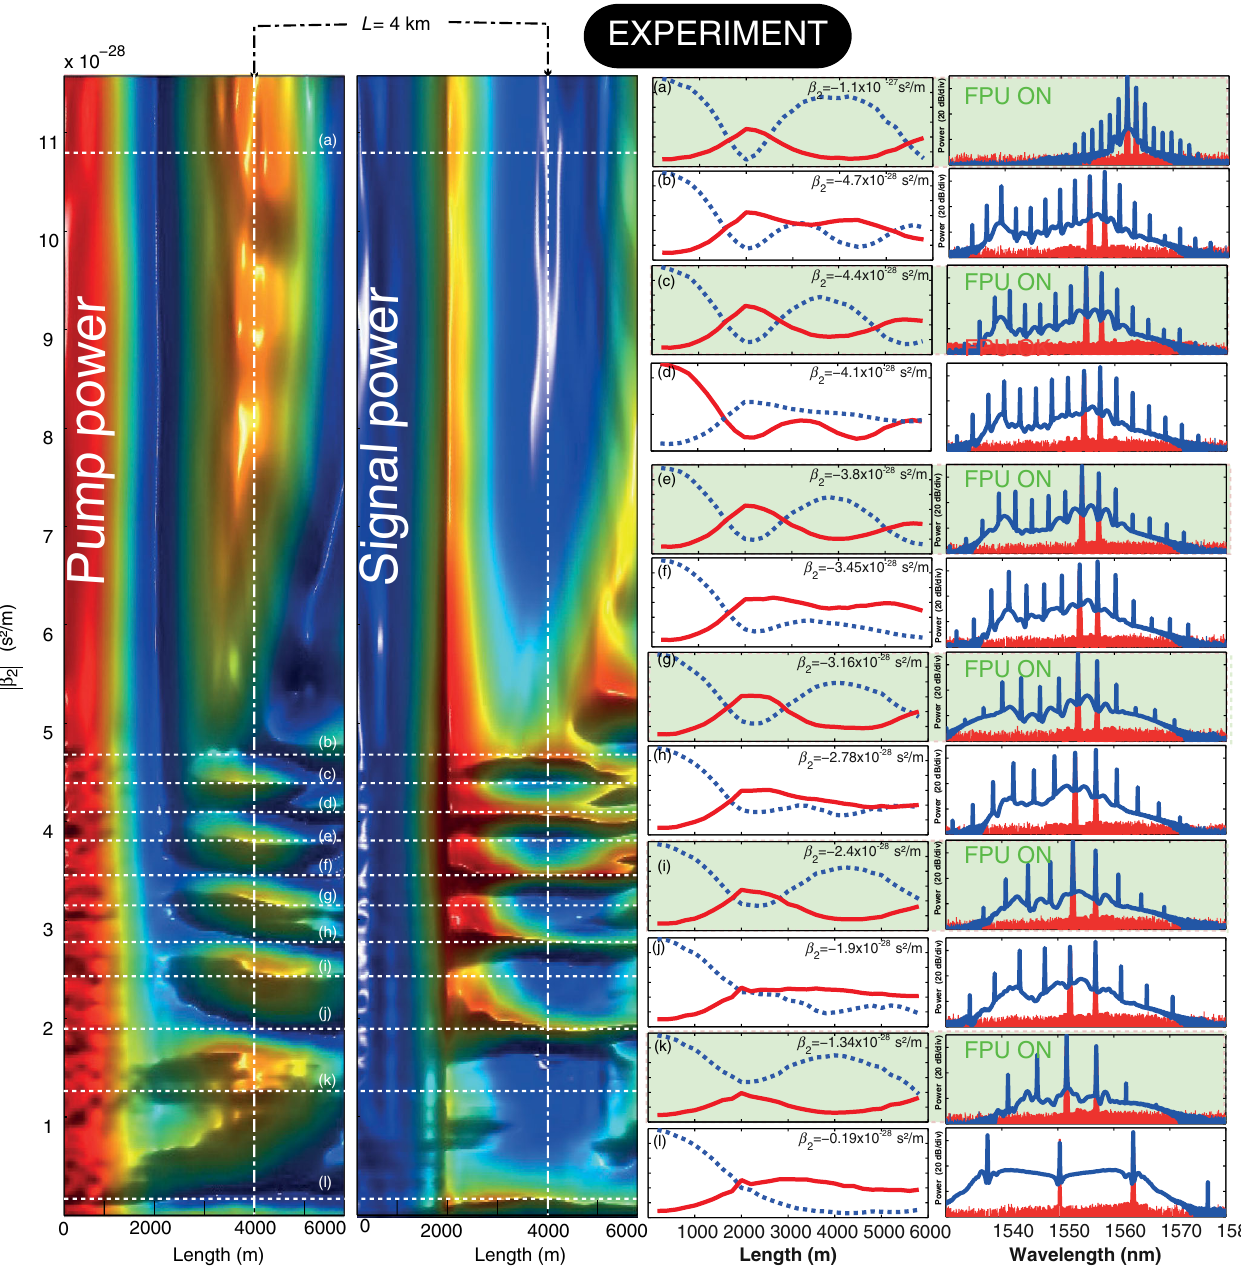
FIG. 4 Experimental data. Left two columns: False color plots of the pump and signal powers versus fiber length and dispersion. The third column: Evolution of the signal power (solid red lines) and of the pump power (dotted blue lines) versus fiber length for specific j β j values. Right column: Corresponding spectra at L ¼ 4000 m (blue lines) and L ¼ 0 (red lines). The pink panels in the two right 2 columns show the cases where FPU recurrence is on, while the white panels show the cases where FPU recurrence is